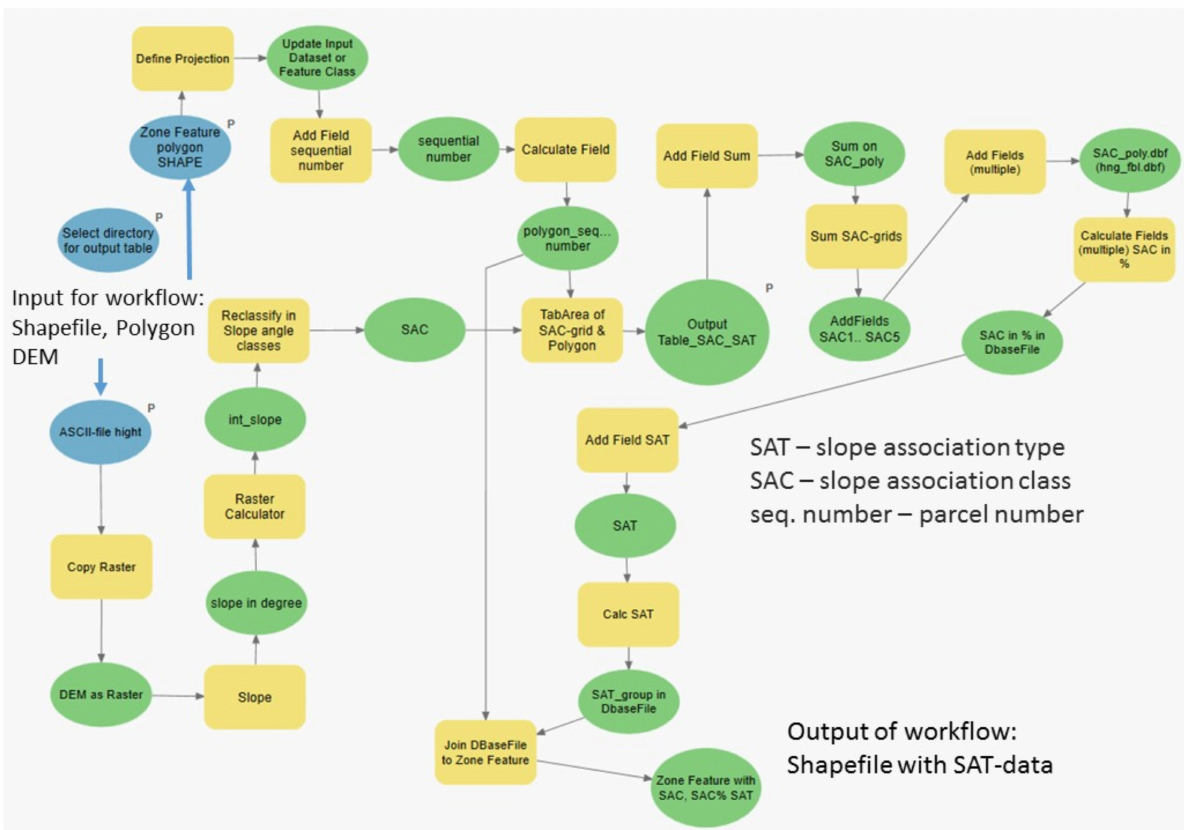
Figure 1. Flow chart to calculate slope association types (SAT) with the ModelBuilder of ArcGISPro 2.7